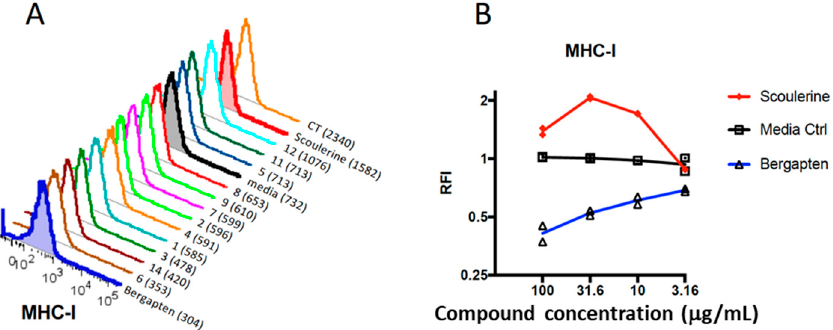
Figure 2. Modulation of immune molecule expression by plant compounds. ( A ) FACS plots showing the median fluorescence intensity (MFI) of MHC-I expression for all selected plant compounds, cells grown in media only, and a control grown with cholera toxin (CT). ( B ) The concentration at which each compound (scoulerine and bergapten) was most active was determined by titrating each compound (four mid-log dilutions starting at 100 µg/mL) and observing the maximal increase (or decrease) in expression of each fluorochrome (Table 2). Data for duplicate assays is presented. Media Ctrl = Media control.